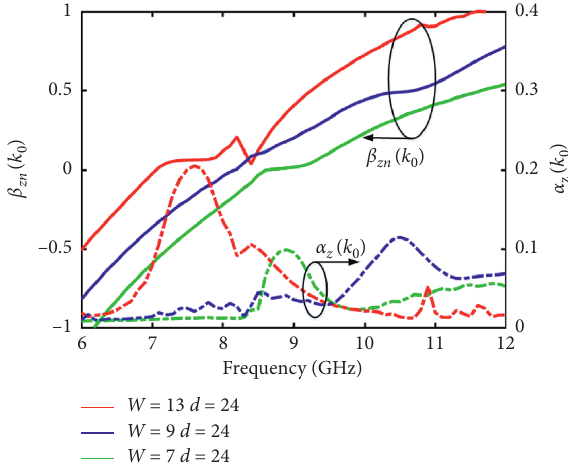
Figure 6: The normalized propagation wavenumbers of the pro- posed periodic antenna with different W ( d �